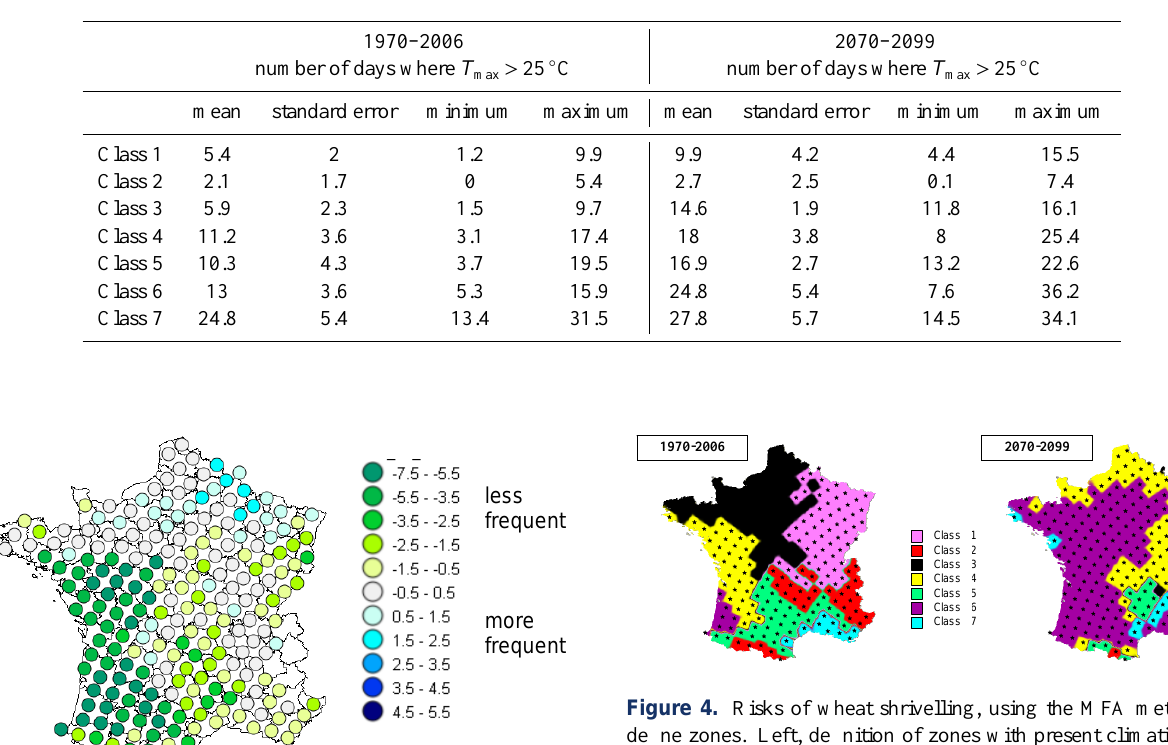
Table 1. Number of days where T max > 25 ◦ C for the 7 defined classes (classes defined on the present period), applied on present and future data, ear emergence at 5 June (like in the present conditions).